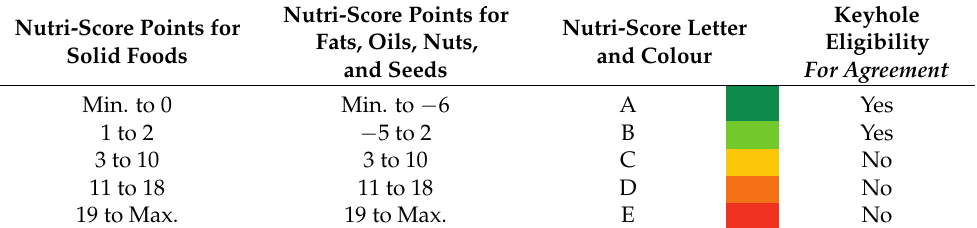
Table 2. Total Nutri-Score points and corresponding letter and colour for the two food groups in the Nutri-Score 2022 algorithm (solid foods and fats, oils, nuts, and seeds). Keyhole Nutri-Score Points for Nutri-Score Letter Nutri-Score Points for Eligibility Fats, Oils, Nuts, and Colour Solid Foods For Agreement and Seeds Min. to 0 Min. to − 6 A Yes 1 to 2 − 5 to 2 B Yes 3 to 10 3 to 10 C No 11 to 18 11 to 18 D No